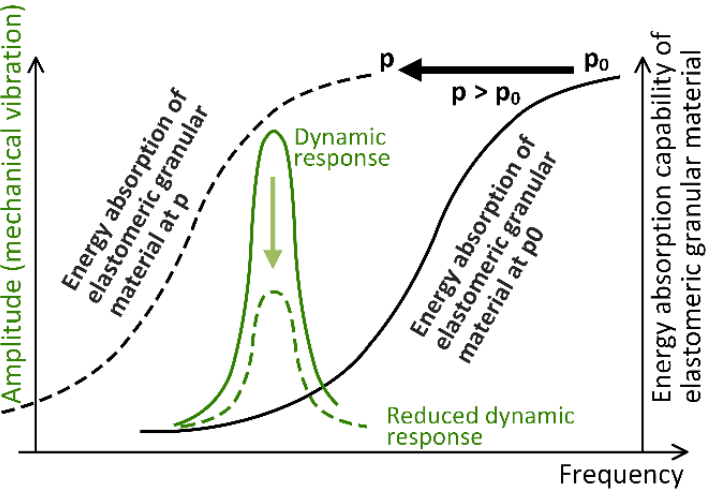
Figure 4. Schematic presentation of the damping element working principle.